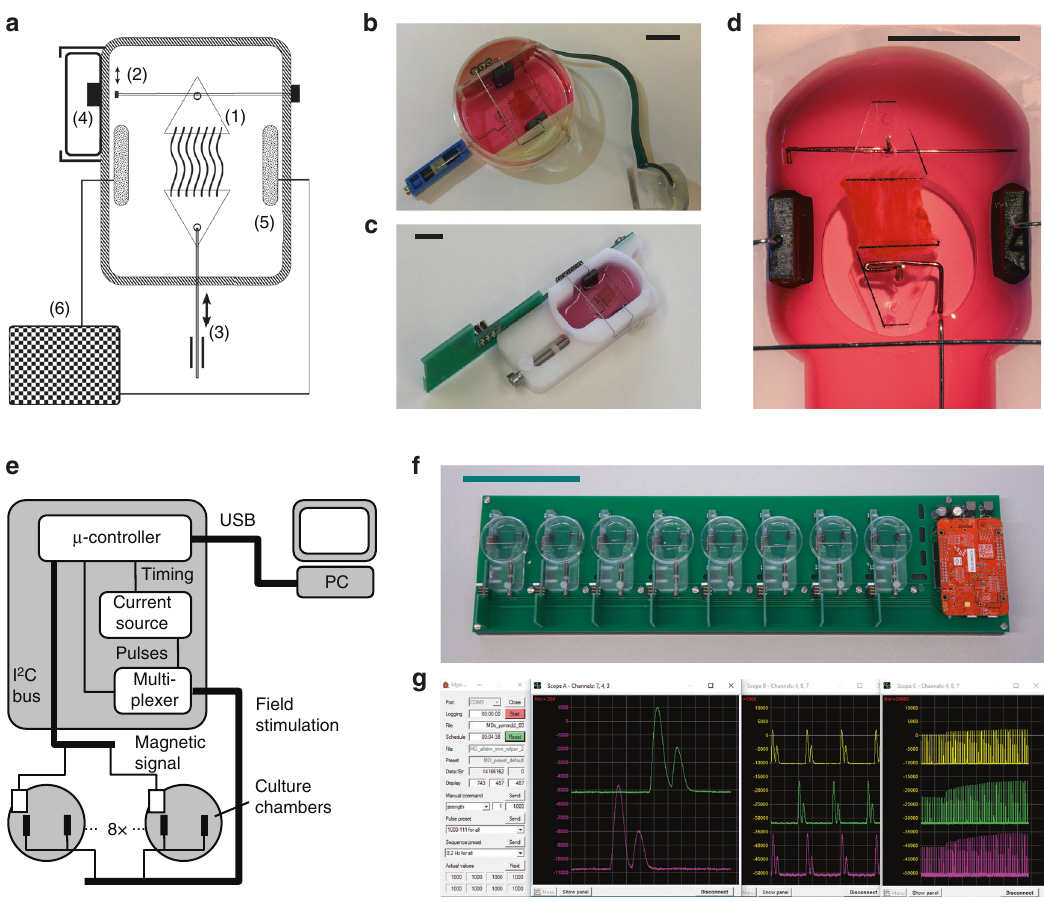
Fig. 1 Biomimetic culture system. a Schematics of the culture chamber depict attachment of tissue slice via plastic triangles (1) to spring wire with magnetic tip (2) and to linear drive (3). Changes in magnetic fi eld are detected by an integrated sensor (4). Field stimulation is provided by graphite electrodes (5) connected to a constant current pulse generator (6). b-c Implementations based on standard dish and machined POM. d Detailed view of tissue slice fi xation and stimulation electrodes. e Schematic of controller electronics. Signals from the magnetic fi eld sensors are processed by a microcontroller that also provides bipolar stimulation pulses via a multiplexed current source. f Control unit and eight biomimetic culture chambers (BMCCs) are combined on a circuit board that can be operated in a standard CO 2 incubator. g Recording software. Data are transmitted via USB to an external PC for recording and scheduled execution of stimulation protocols. Black bars represent 10 mm, the green bar 100 mm